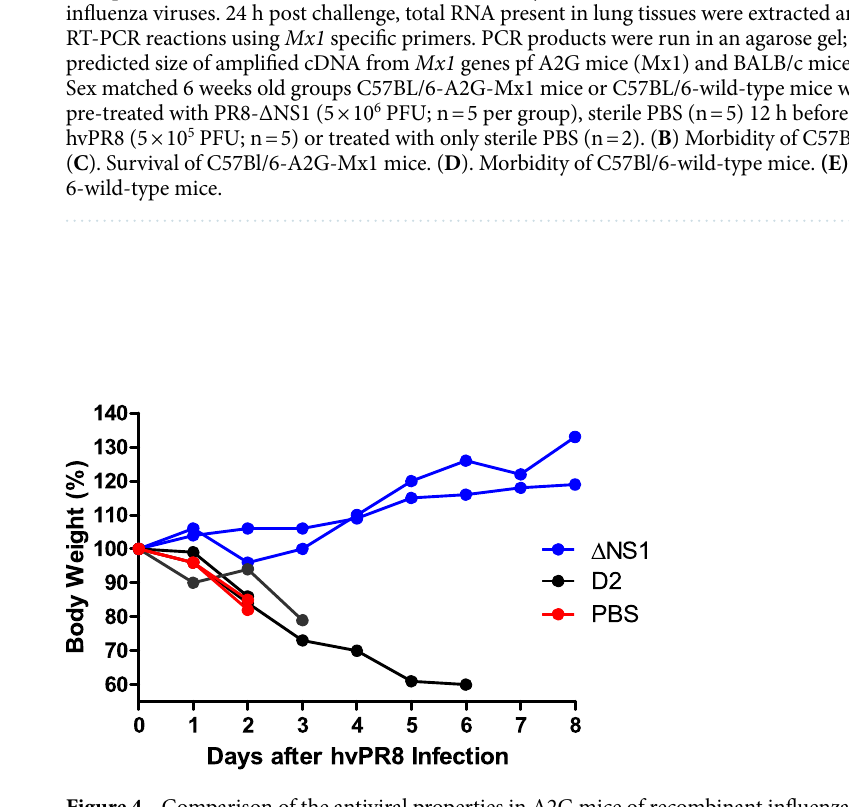
Figure 4. Comparison of the antiviral properties in A2G mice of recombinant influenza A viruses ΔNS1 and D2. A2G mice were intranasally treated with PBS or 2.5 × 10 5 PFU of ΔNS1 or D2 viruses for 24 h before infection with 5 × 10 6 PFU of hvPR8 influenza virus. Bodyweight changes and survival were monitored. Data shown are from individual